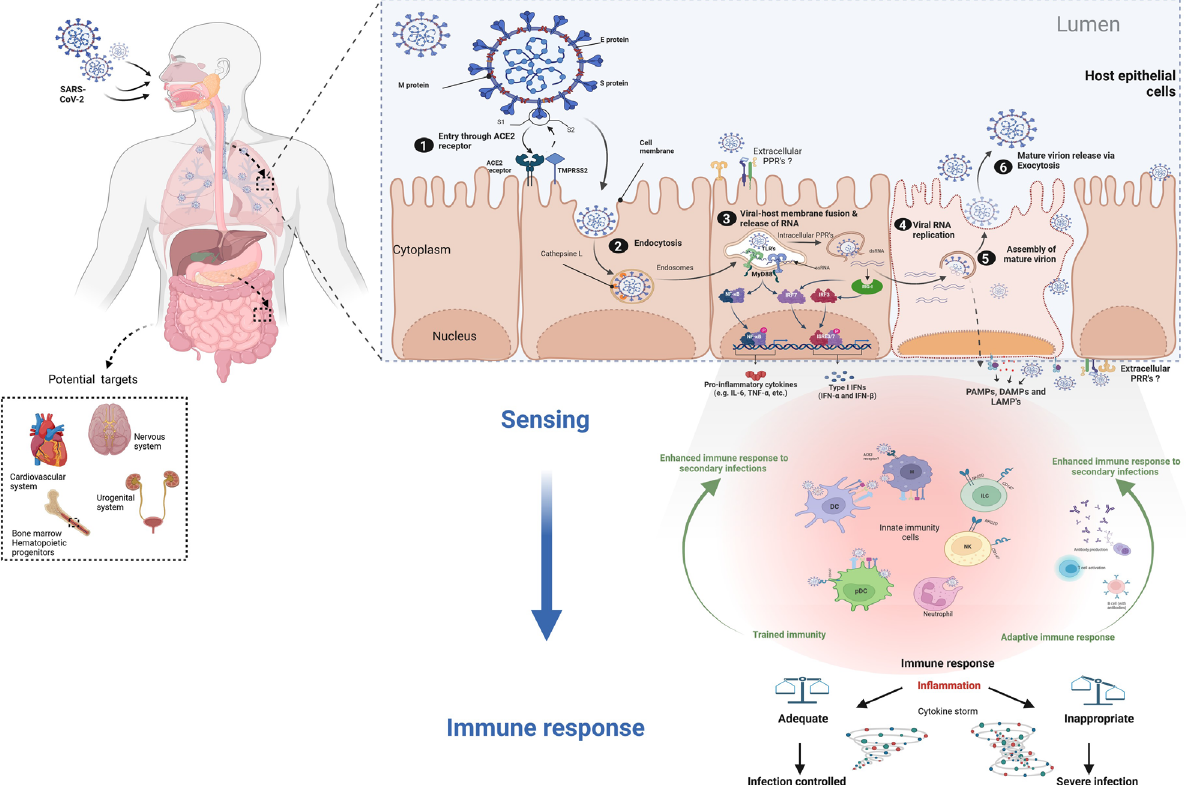
Figure 1. The infection cycle of SARS-CoV-2 in cells expressing receptor. ACE2 is not only largely expressed in the lung and intestinal epithelium, but also in other organs and systems where the virus can cause damage (dotted square). SARS-CoV-2 proteins involved in virus entry into cells are the M protein, E protein, and S protein. SARS-CoV-2 infection respiratory epithelium: 1) the S protein binds to the receptor and splits into two subunits (S1 and S2). The S1 subunit is recognized by the cellular receptor ACE2. 2) TMPRSS2 and cathepsin L are other receptors involved in SARS-CoV-2 endocytic entry. 3) viral RNA is released into